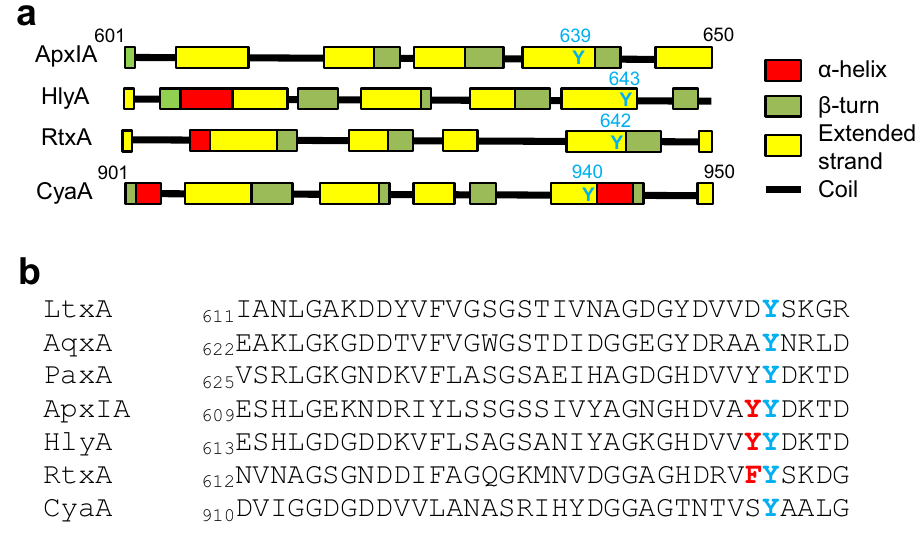
Figure 3. A conserved tyrosine residue is present in the acylated segment of RTX toxins. ( a ) Prediction of secondary structures in CyaA (residues 901–950) and 601–650 of ApxIA, HlyA and RtxA was performed using SOPMA software 71 . Highly conserved Y639 from ApxIA, Y643 from HlyA, Y642 from RtxA and Y940 from CyaA are highlighted by a blue color. ( b ) ClustalW sequence alignment of a partial sequence of the acylated segment of CyaA and corresponding sequences of related RTX toxins. LtxA, Aggregatibacter actinomycetemcomitans (UniProtKB P16462); AqxA, Actinobacillus equuli (UniProtKB Q8KWZ9); PaxA, Pasteurella aerogenes (UniProtKB Q9RCG8); ApxIA, Actinobacillus pleuropneumoniae (UniProtKB P55128); HlyA, Escherichia coli (UniProtKB P08715); RtxA, Kingella kingae (UniProtKB A0A1X7QMH9); and CyaA, Bordetella pertussis (UniProtKB P0DKX7). The highly conserved residues Y639 of ApxIA, Y643 of HlyA, Y642 of RtxA and Y940 of CyaA are highlighted by a blue color. The non-conserved Y638 of ApxIA, Y642 of HlyA and F641 of RtxA are highlighted by a red